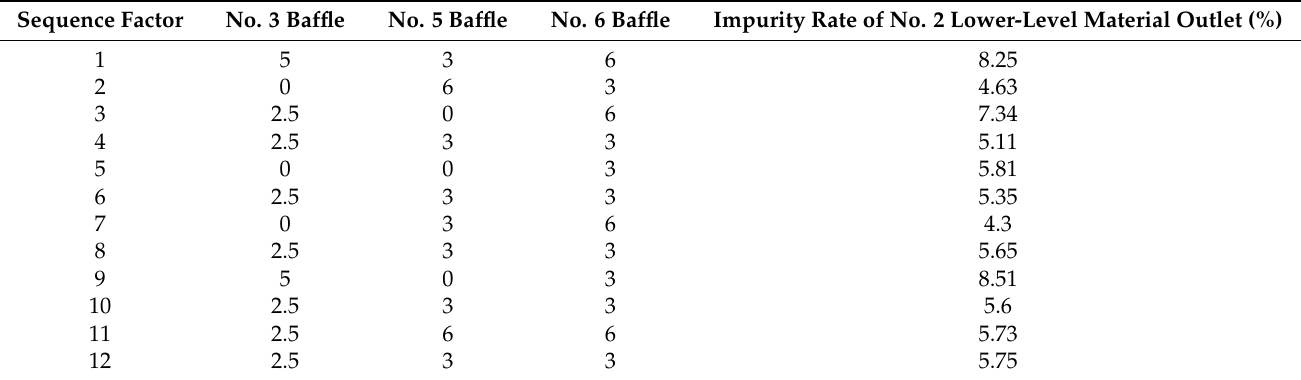
Table 9. Test results of double-layer tea winnowing machine of pan-fried green tea.